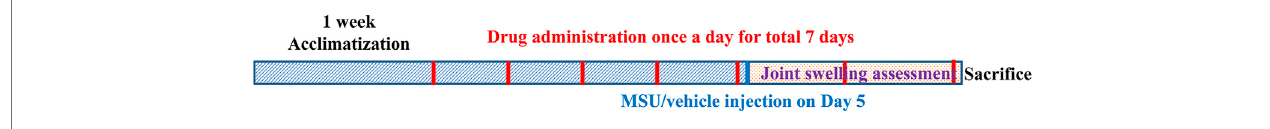
FIGURE 1 | Timeline of the present